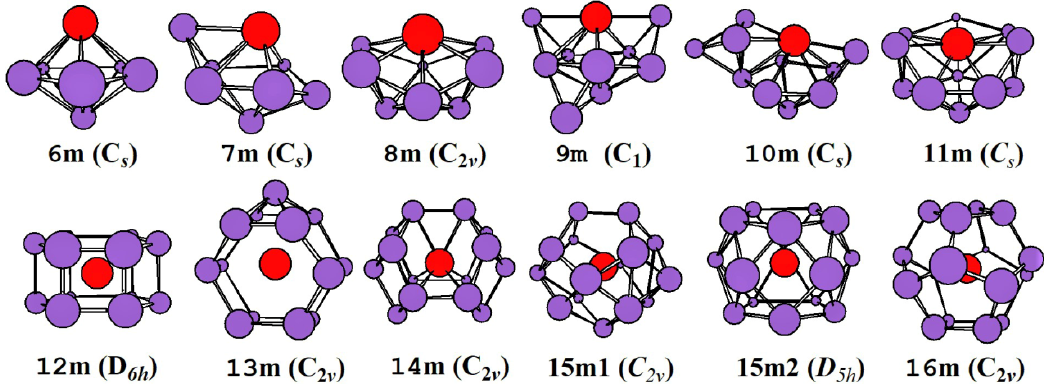
Figure 1. The lowest-energy structures of ZrSi n ( n = 6–16) and their point group.